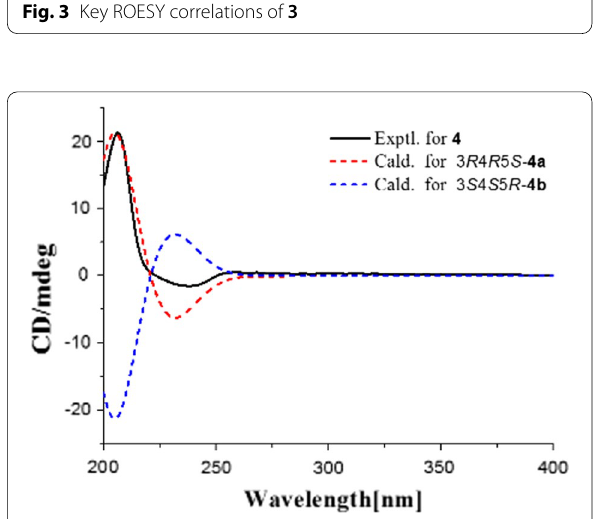
Fig. 4 Experimental and calculated ECD spectra of